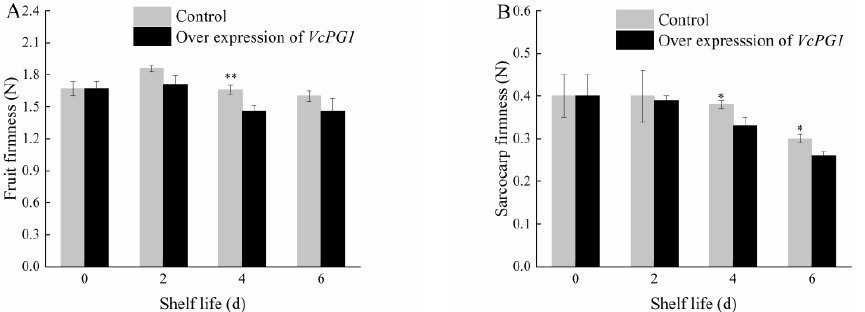
Figure 10. Changes in fruit firmness ( A ), and sarcocarp firmness ( B ) with overexpression of VcPG1 in blueberries at 20 °C. Mean ± SE of three replicate experiments are shown. Asterisks indicate significant differences between control and treated fruit (* p < 0.05, ** p < 0.01).